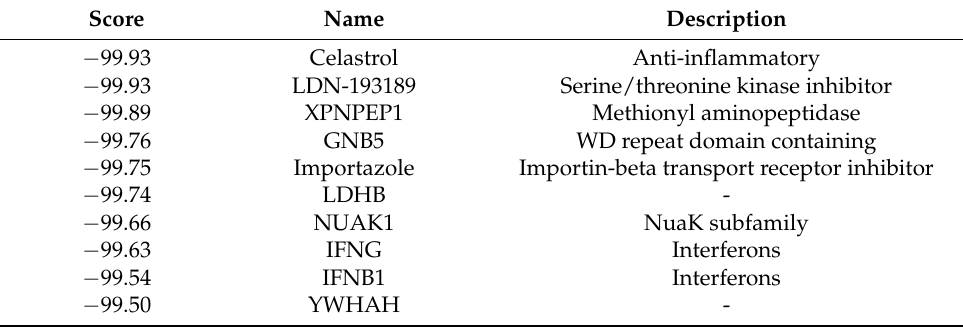
Table 2. CMap prediction of the top 10 drugs for fluorosis